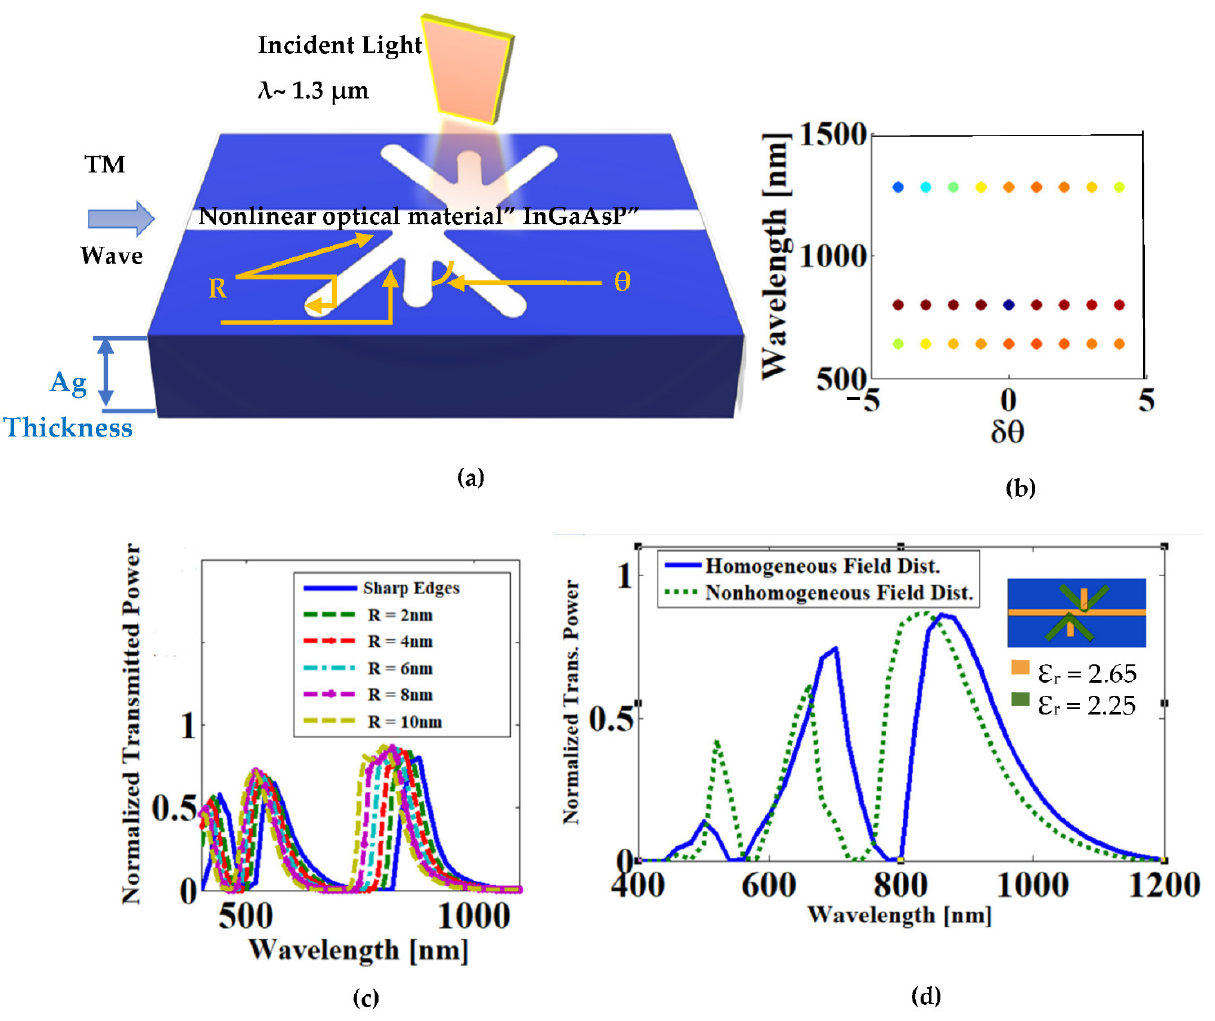
Figure 6. Fabrication tolerance due to the variation in angle “ θ ”, the radius of the curved edge “R”, and the pump light field distribution. ( a ) 3D sketch model for the proposed tunable multi-channel ban-pass filter; ( b ) variation in angle “ θ ” Note: Every line (light intensity e 0 ) corresponds to one of the three passing wavelength channels, and the colored dots for each line indicate the variations in transmission efficiency values; ( c ) transmission spectrum with different curved edges “R”; ( d ) the variation in the pump light field distribution within the structure of the waveguide. Inset: the different refractive indices of the NLO material due to the non-homogenous pump light field distribution.